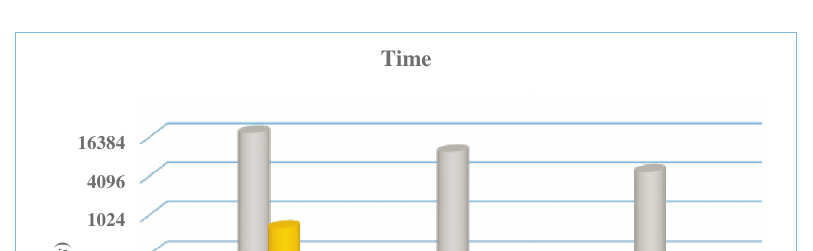
Figure 10. Area results.